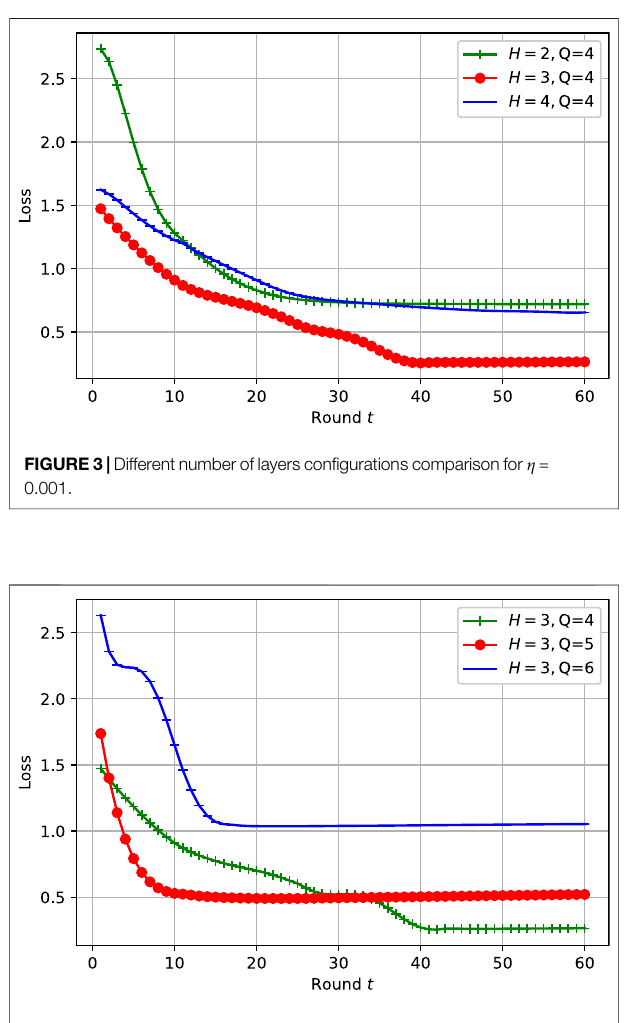
FIGURE 4 | Different number of neurons per layer con fi gurations comparison for η (cid:1) 0.001.